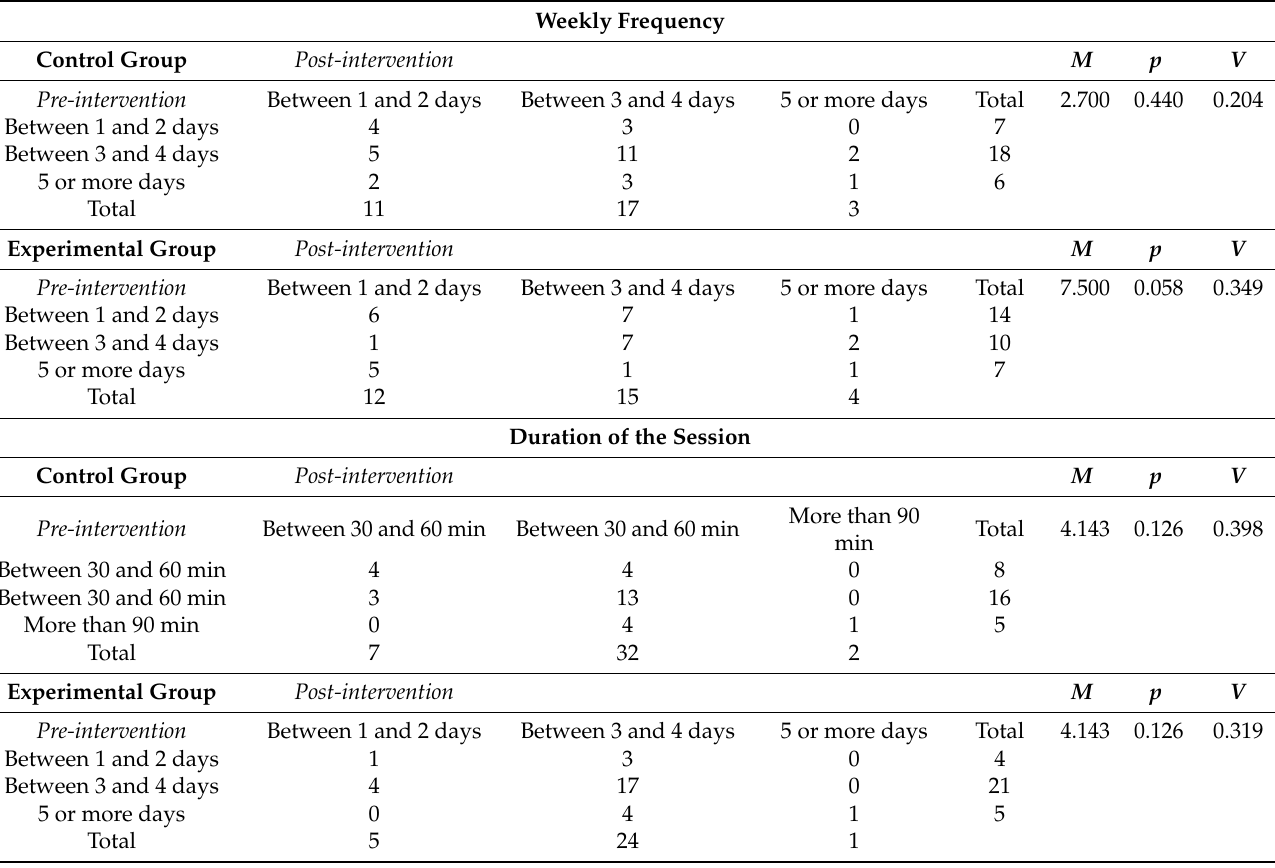
Table 4. Evaluation of the intervention: changes in sports